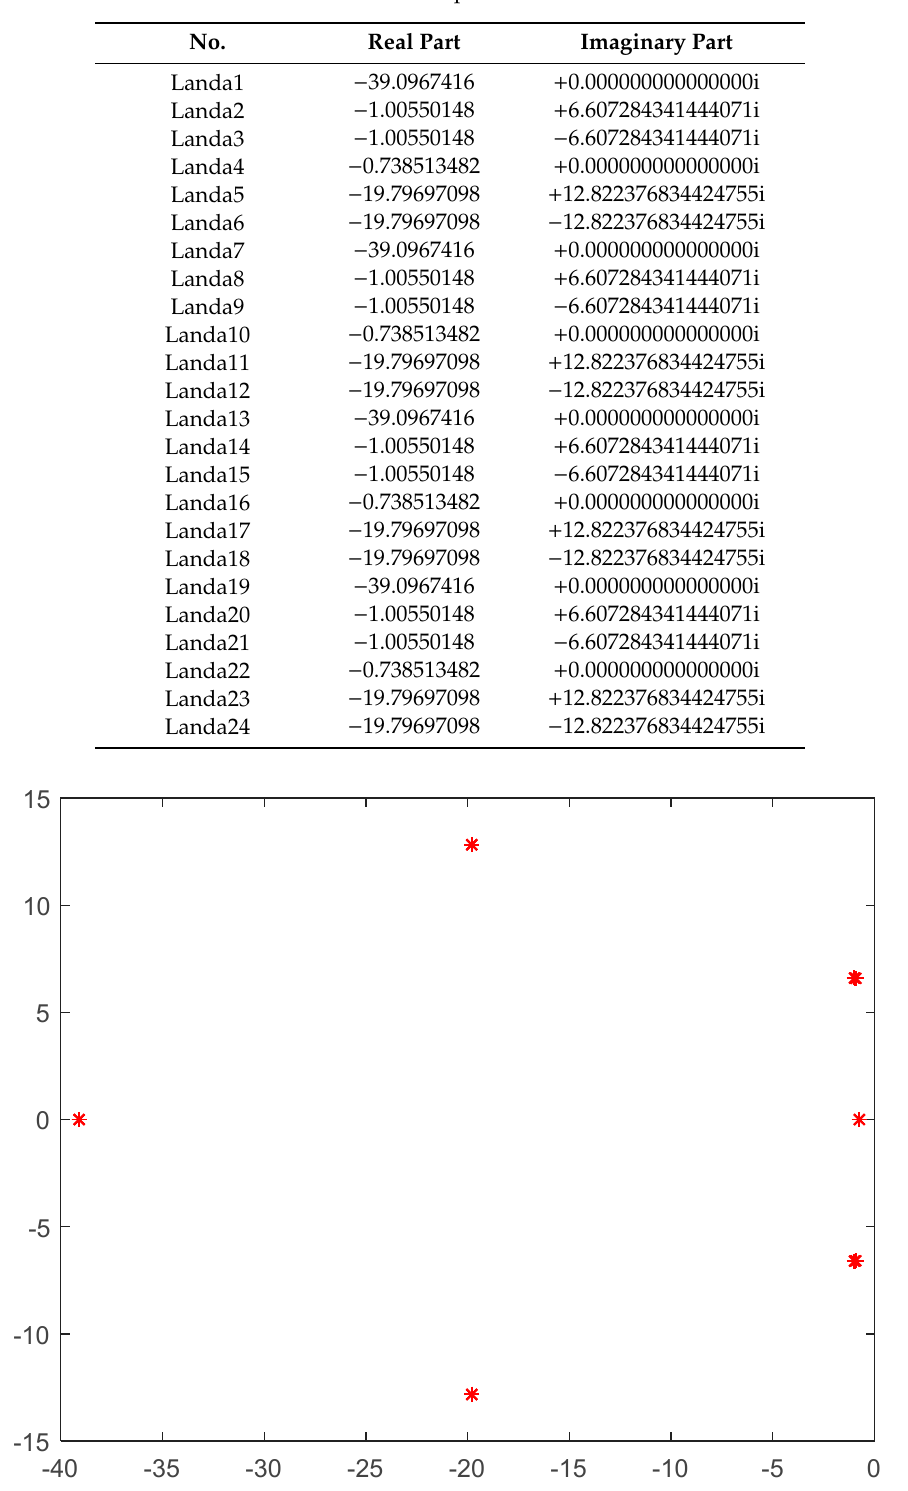
Table 1. The data of special matrix values.